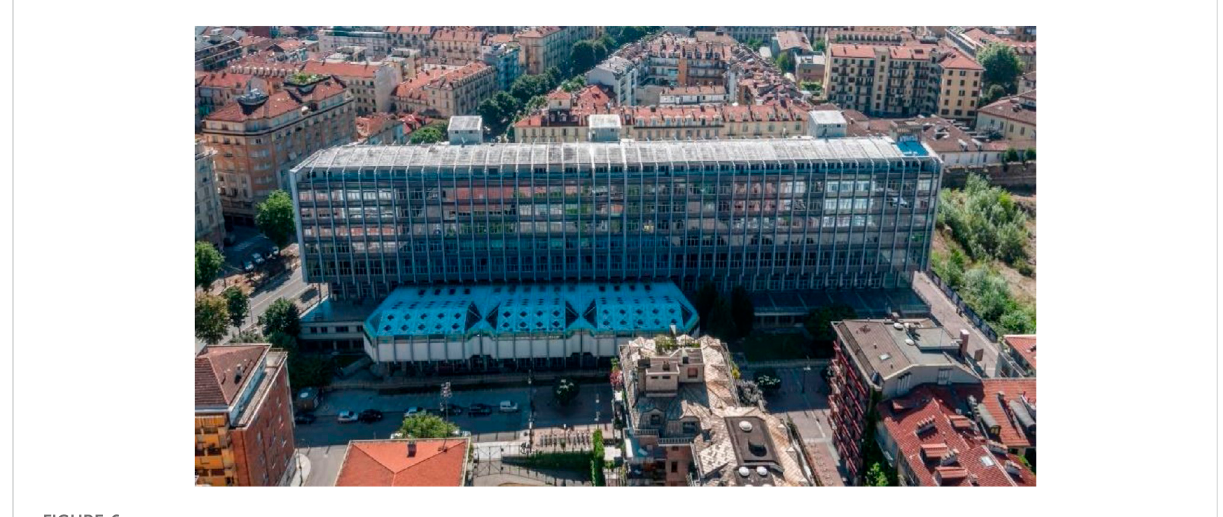
FIGURE 6 Second demonstrator, Palazzo Nuovo.